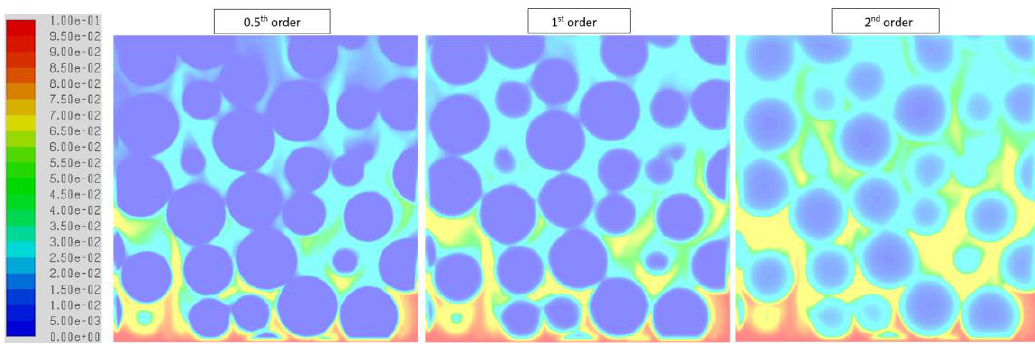
Figure 4. PR-DNS results for mass fraction of specie A (x A ) through a geometry of spherical particles (at plane y = 0; ε = 0.352, 𝜙 = 10, Pr = 1) for different reaction orders (0.5th, 1st, 2nd), respectively.